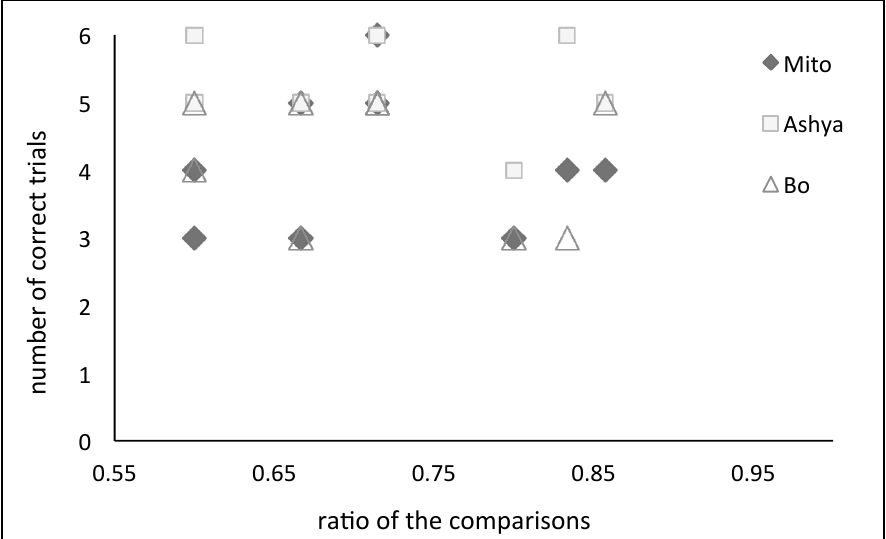
Figure 1. Ratios of comparisons and number of correct